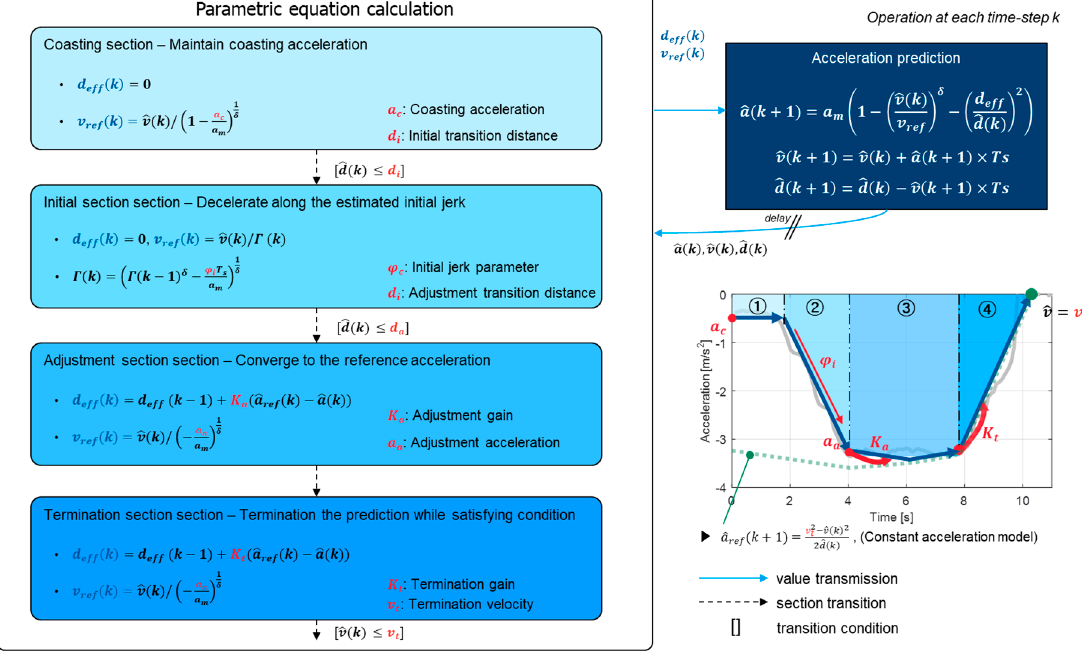
Figure 7. Model prediction process.